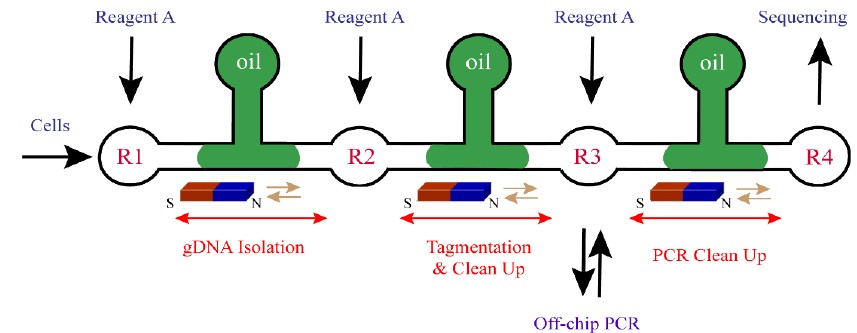
Figure 7. Schematic of microfluidic workflow [81]. Water or aqueous bu ff er exists in each reservoir (R1–R4). Cells are added in R1 and incubated, followed by adding of reagent A (magnetic beads and binding bu ff er). The beads binding with DNA are moved to R2 and then DNA is eluted from the beads in reaction bu ff er. DNA fragmentation and adapter ligation reaction are performed in R2. After reagent A is added and beads are moved to R3, DNA is eluted from the beads into water. DNA is transferred for o ff -chip PCR amplification and then moved back to R3. With Reagent A added in R3 and beads moved to R4, purified DNA is prepared for